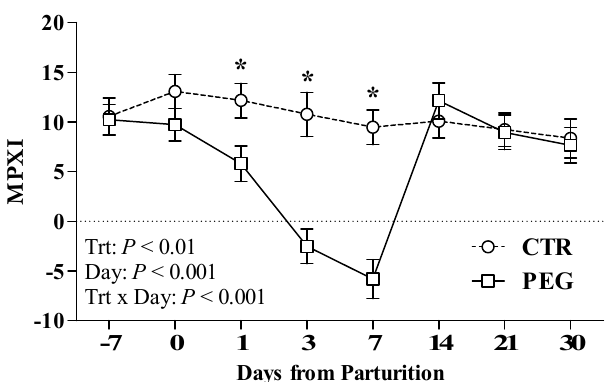
Figure 4. E ff ect of Pegbovigrastim on MPXI. Least-squares means ± standard error of neutrophil myeloperoxidase index (MPXI) are evaluated by using ADVIA 2120 Hematology Analyzer during the transition period of Simmental cows treated either with 2 subcutaneous injections of pegbovigrastim (PEG) or saline solution (CTR) at − 7 days relative to calving and within 6 h after calving. Asterisks (*) indicate di ff erences at p < 0.05.